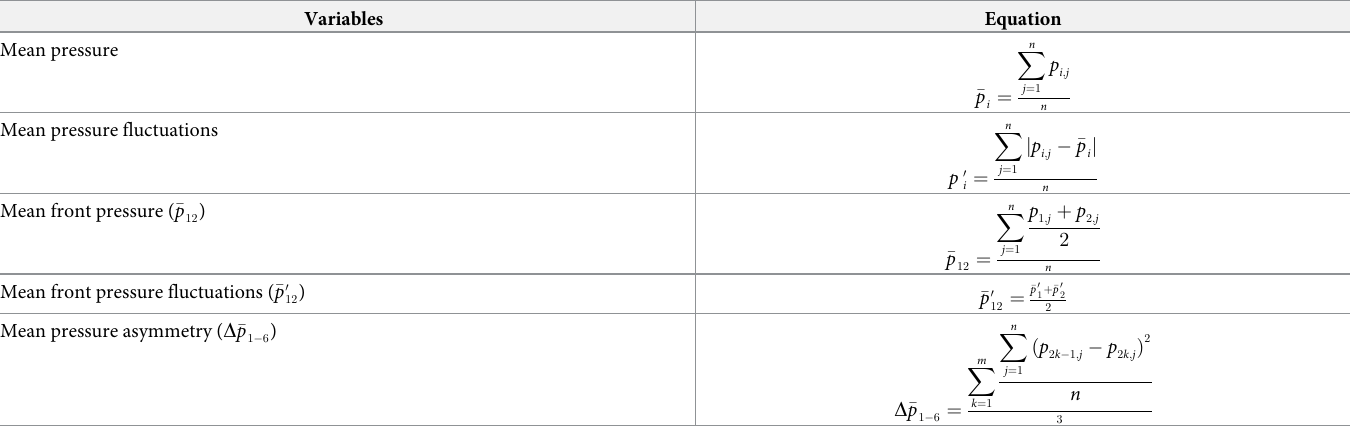
Table 1. Pressure-based variables form LLP measurements used in this study. Definition of mean pressure and mean pressure fluctuations are included to clarify the mathematical definition of the variables used for this study. n: number of data points in a measurement; i: index of the